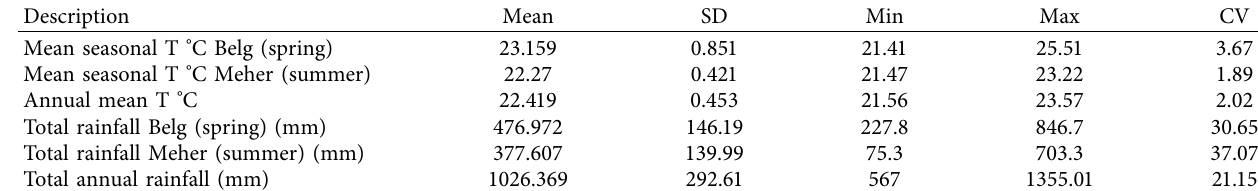
Table 3: Summary of descriptive analysis for meteorological data (1994–2021).